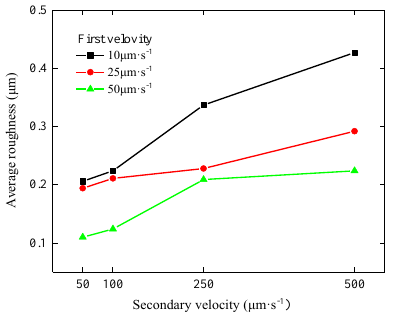
Figure 10. Average roughness of slit side walls using different initial and secondary velocities.